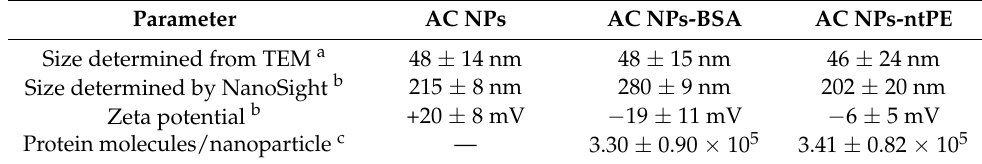
Figure 3. Strategy for conjugation of ntPE or BSA onto nanoparticles (NPs). Diagram of strategy for coupling through the free sulfhydryl moiety of ntPE-CENLFQ onto the surface of NPs using EMCH, followed by specific cleavage by TEV protease. BSA, as a control protein to replace ntPE, was coupled after chemical modification of amine moieties using Traut’s reagent. Table 1. Physicochemical characterization of nanoparticles (NPs).